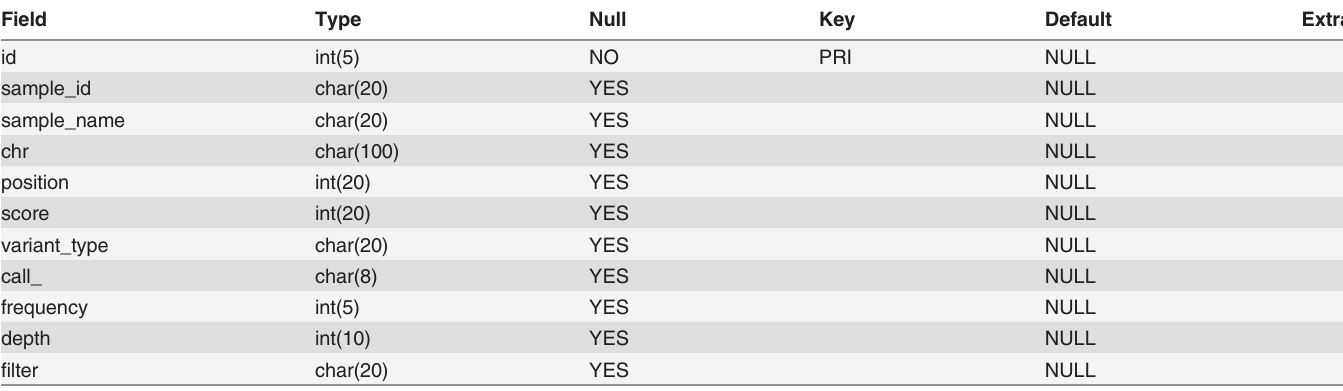
Table 3. The required table structure of the input data for SNPer computational analysis based on MySQL. Field